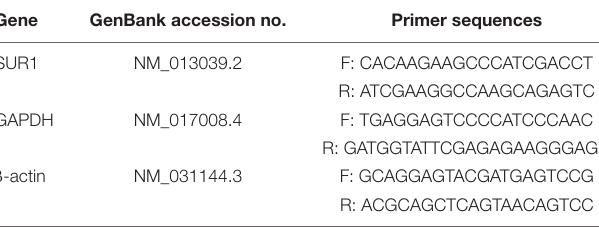
TABLE 1 | Primers used for real-time RT-PCR.